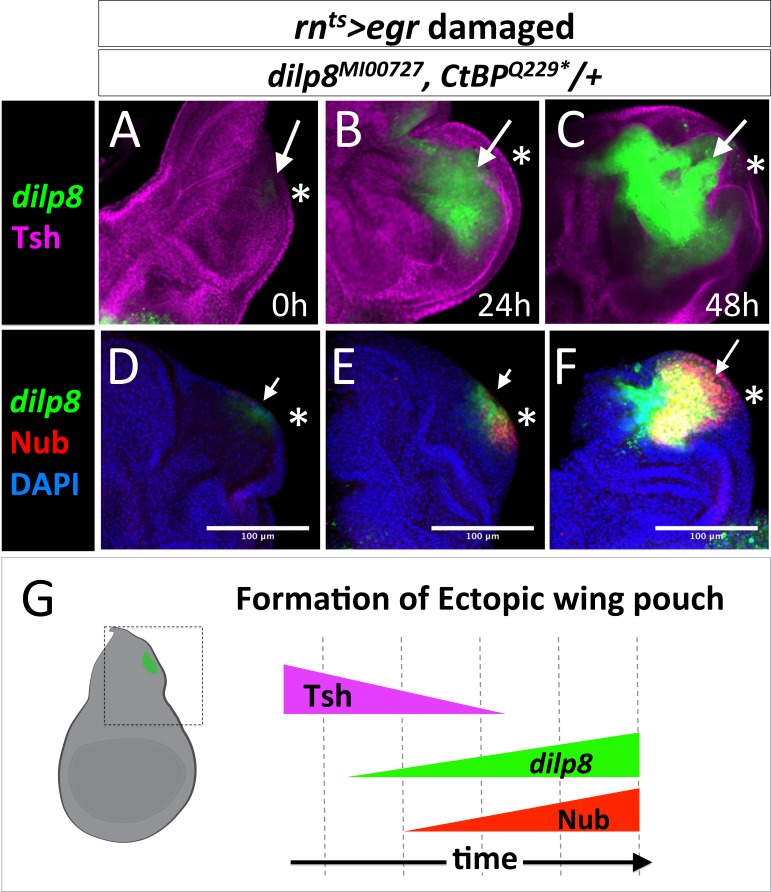
Timing of dilp8-GFP spot appearance in the notum relative to Tsh downregulation and onset of Nub expression.(A–F) Close-up of the notum/ectopic pouch in dilp8MI00727, CtBPQ229*/+ following rnts>egr induced damage on day 7 for 40 hr. The transcription factor Teashirt (Tsh) is downregulated in the wing pouch during normal development and Nubbin (Nub) is expressed in the wing pouch (Zirin and Mann, 2007). Wing discs with dilp8-GFP and either anti-Tsh (A–C) or anti-Nub (D–F). Note that dilp8-GFP expression partially overlaps the Nub-positive domain, but there are regions that express only dilp8-GFP or Nub. (G) Model of timeline of marker expression during the formation of the ectopic pouch: dilp8-GFP is initially co-expressed with Tsh in the notum. Tsh is progressively downregulated as the pouch forms and Nub starts to be expressed.